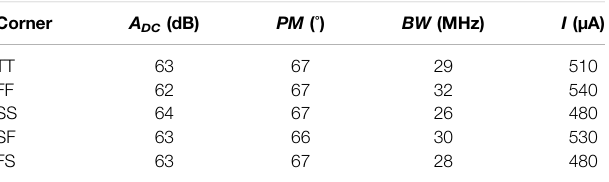
TABLE 3 | Simulated characteristics of the two-stage fully differential ampli fi er in this work.